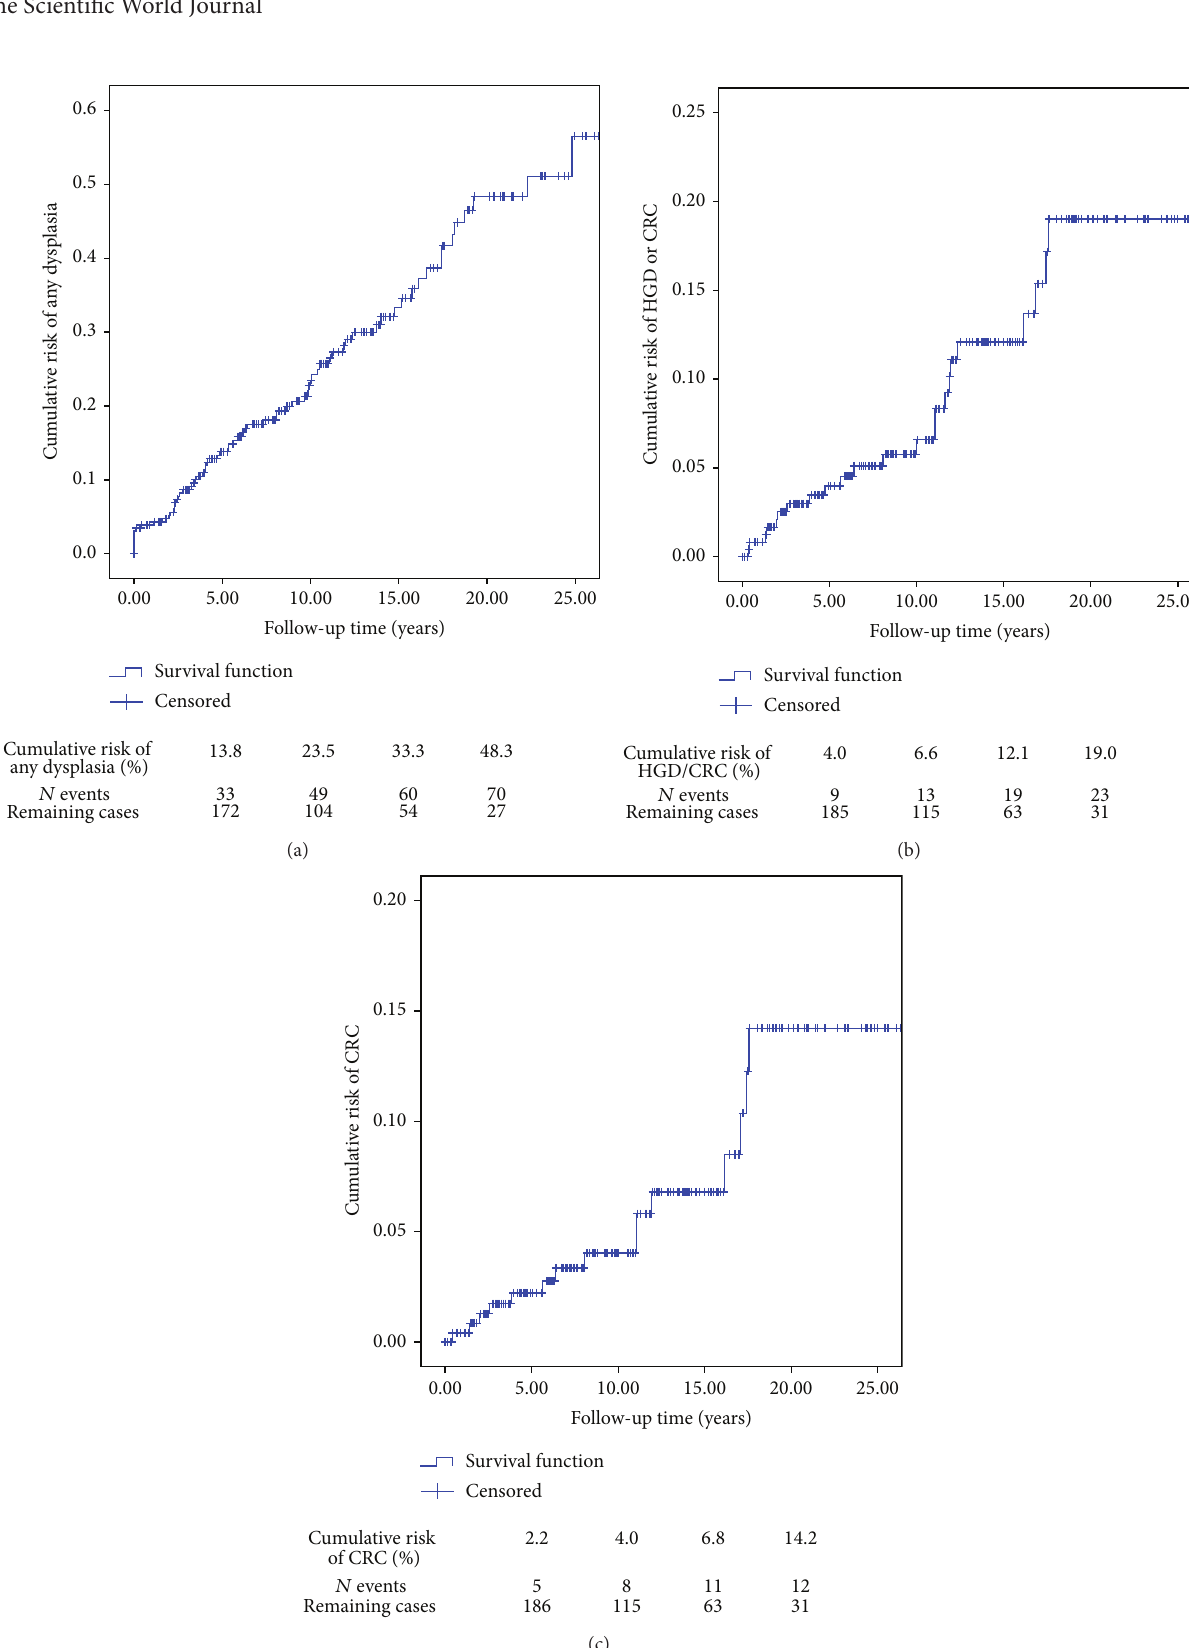
Figure 1: (a) Cumulative risk of any dysplasia. (b) Cumulative risk of HGD and CRC. (c) Cumulative risk of